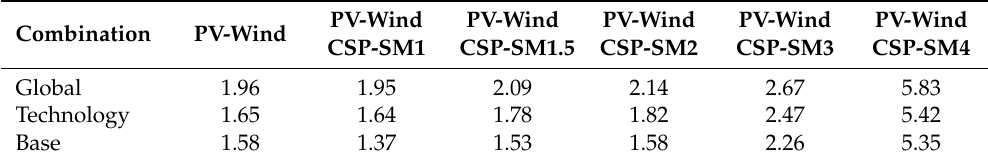
Table 5. Mean-risk ratios (12) of the global, technology and base fronts without the maximum-cost constraint for the different